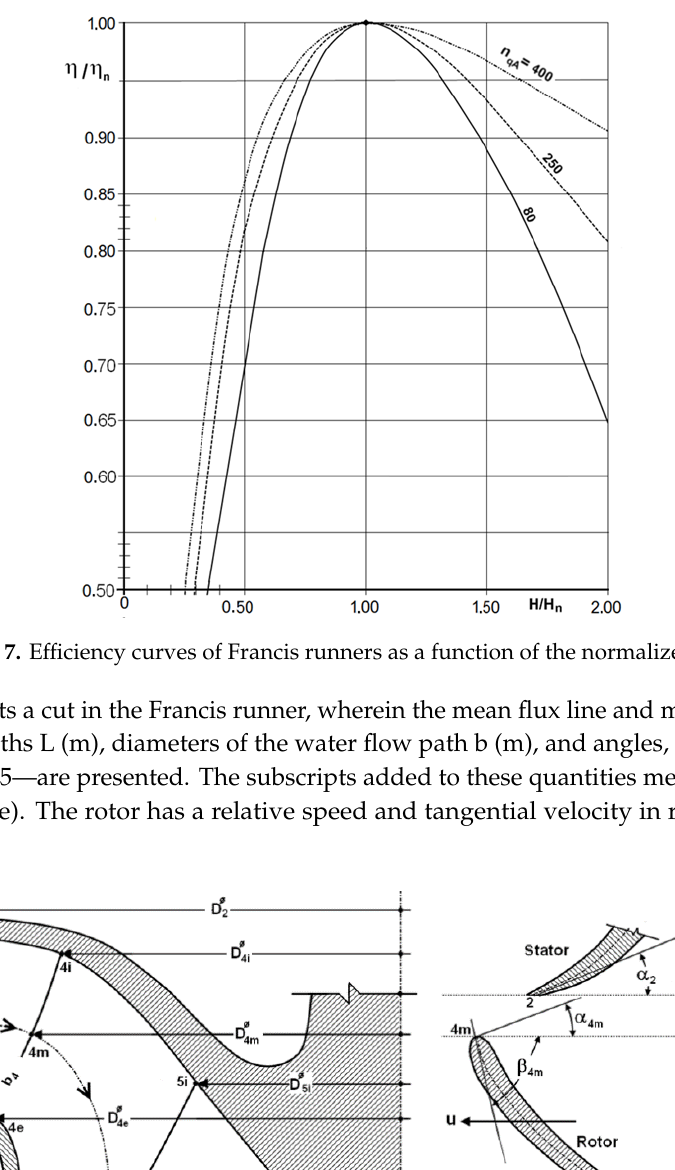
Figure 8. Average flux line and main dimensions and angles for the reaction turbines.